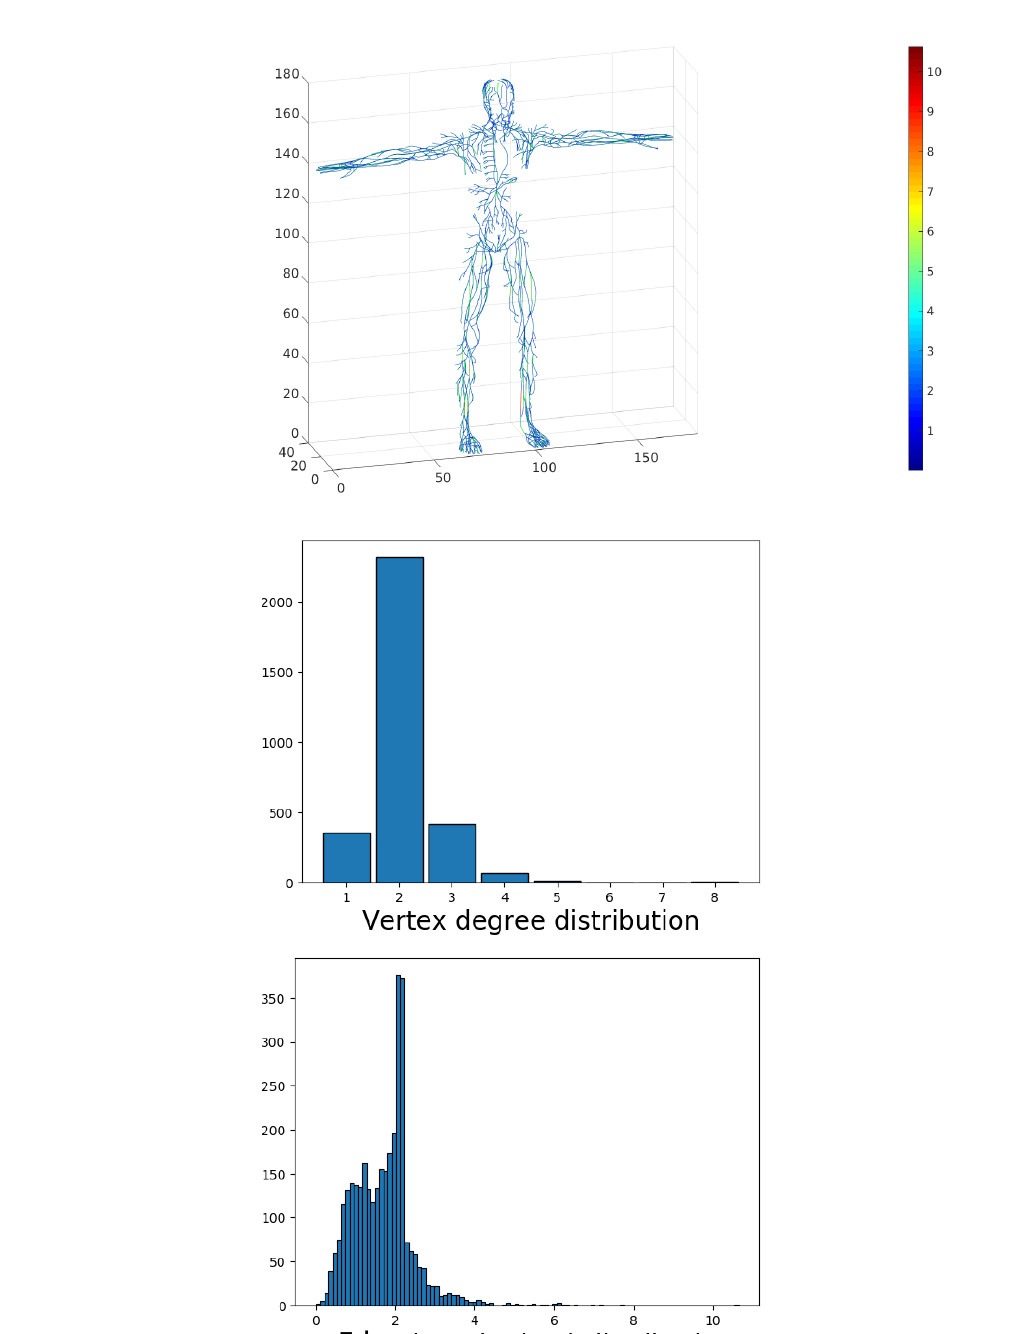
Figure 15. ( Top ) The basis graph model in 3D color code specifies the equal edge lengths; ( Middle ) degree distribution of vertices; ( Bottom ) edge lengths’ distribution (note that these characteristics are for the intermediate model; the final uniform network graph model properties are presented in Section